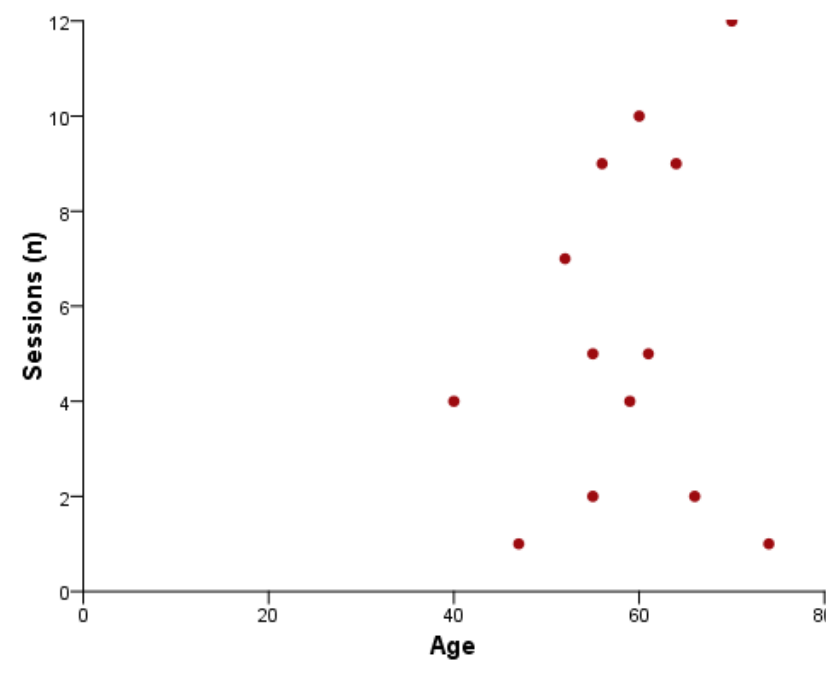
Figure 1. Scatter plot of Age vs. Sessions.